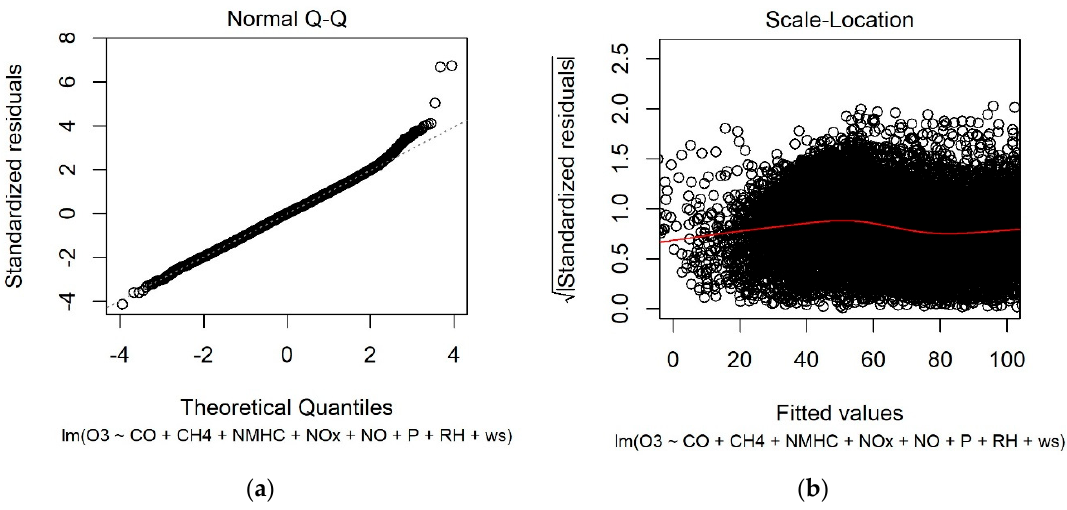
Figure 7. ( a ) Normal Q-Q plot and ( b ) scale-location plots. lm is the function implementing multiple linear regression (MLR) in the R software.